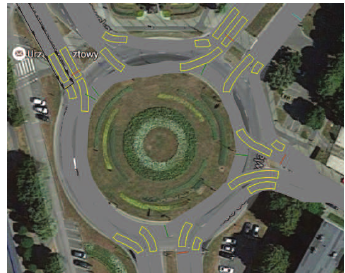
Fig. 5. Vissim alternative model of turbo roundabout The modelled turbo roundabout introduces a modification for Rycerska street: its entrance and exit become wider to include an additional lane. The main direction of the traffic flow in this roundabout is the stretch from Marszałkowska to Lubelska streets for its highest total traffic